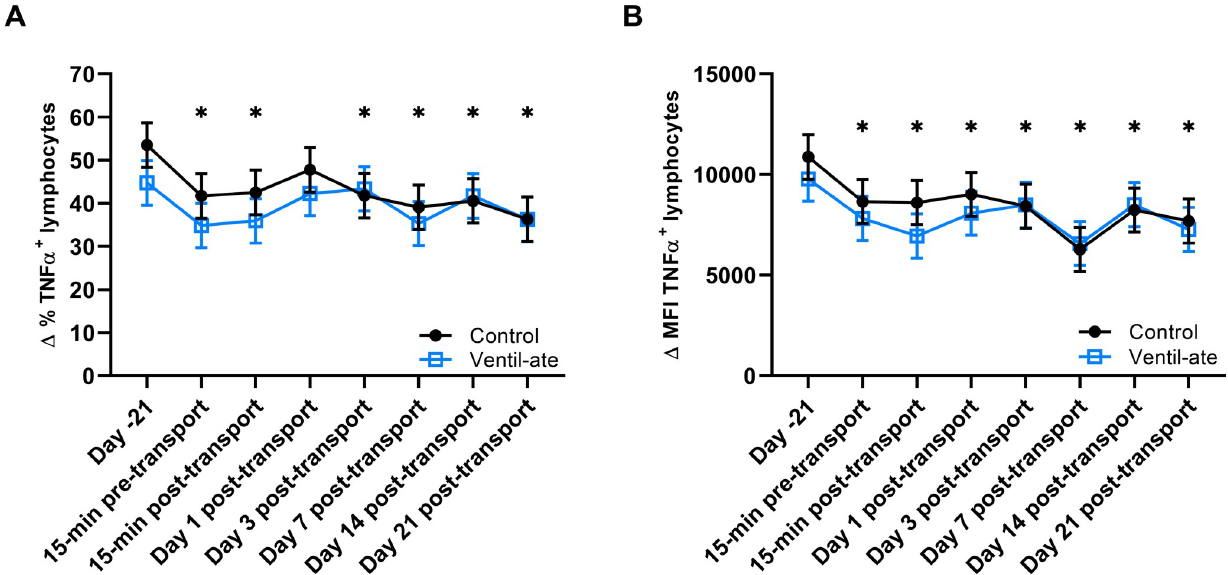
Fig 7. Change ( Δ ) in the (A) percentage (%) and (B) mean fluorescence intensity (MFI; geometric mean) of TNF α + lymphocytes after stimulation and with media values included as a covariate. For illustrative purposes, the figure displays results (least squares means ± SE) from the analyses that included the group-by-time interaction; however, the significant differences shown were determined from the analyses with only group and time included as main effects. (A–B) Significant time effects were observed ( P = 0.0004 and P < 0.0001, respectively). � denotes a significant difference from baseline (Day –21). TNF α , tumor necrosis factor